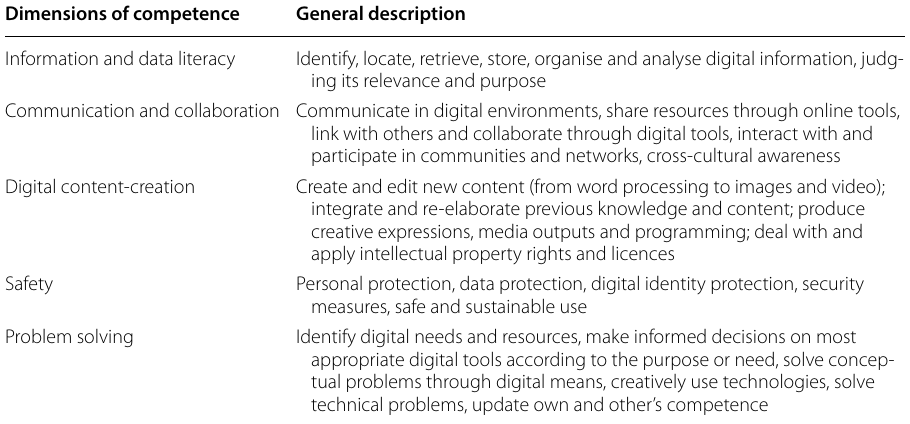
Table 1 An overview of the DIGCOMP competences and their general description, according to Ferrari